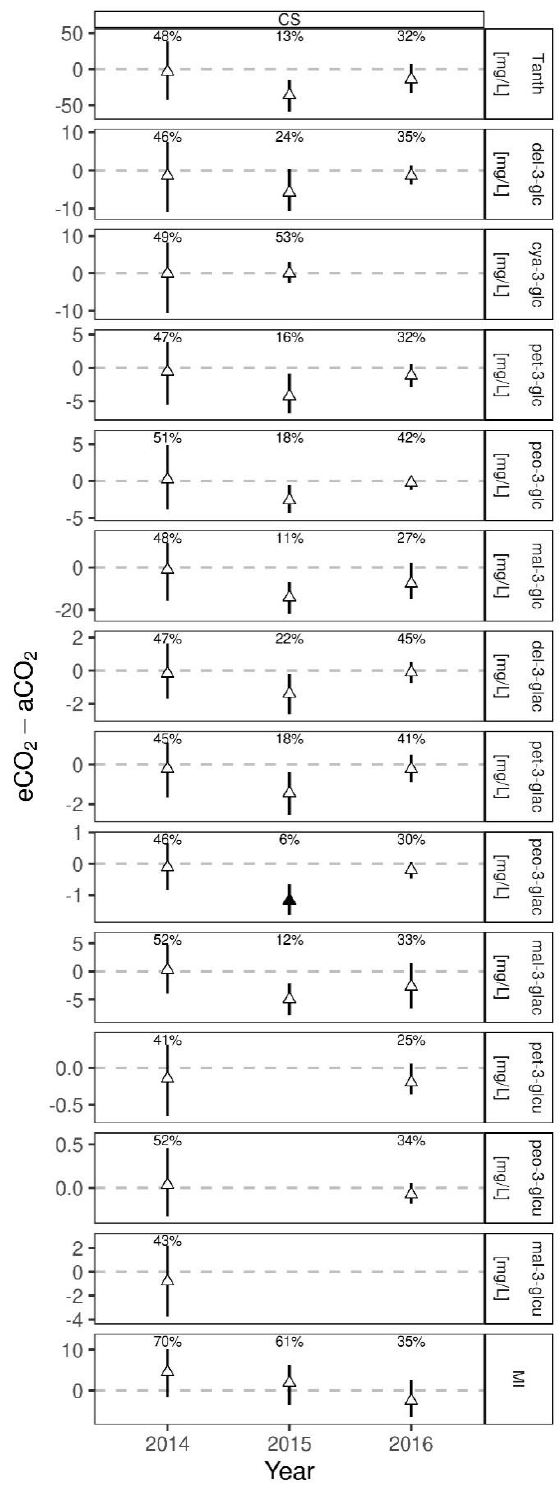
Figure 7. Posterior predicted difference (median and 50% HDI) between eCO 2 and aCO 2 for each measurement year from Bayesian generalized linear mixed effects models on anthocyanins and monomeric index (MI) in Cabernet Sauvignon (CS) wines. Percentages represent the probability of eCO 2 -aCO 2 > 0. Filled symbols indicate “significant differences”, if the probability is >90% (positive difference) or <10% (negative difference).